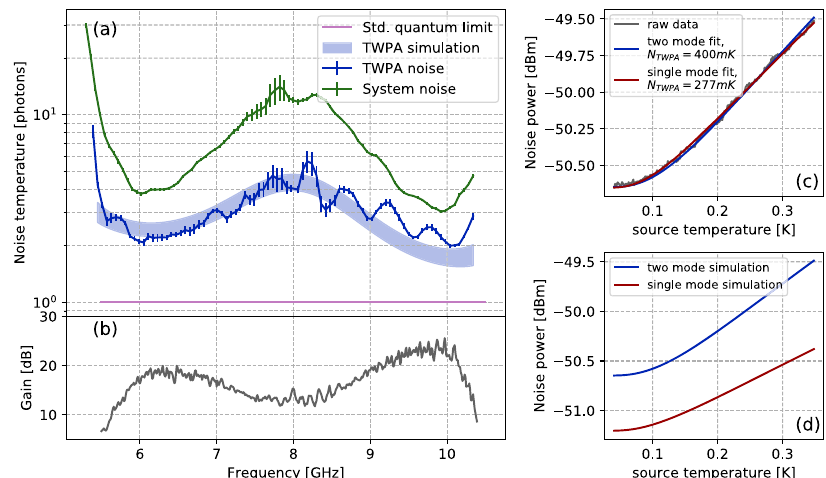
Fig. 4 Noise characterization. a Noise temperature of the ampli fi cation chain (green) and the reversed Kerr TWPA (blue) compared to the standard quantum limit (SQL) across ampli fi cation band in terms of number of added photons. The device is pumped at 8 GHz and tuned to external magnetic fl ux Φ Φ = 0.5. The blue shadow area indicates the result of the theoretical simulations considering power dependent losses. b Corresponding gain pro fi le. ext / 0 c Comparison between output noise power fi tted to noise models including and excluding idler mode noise input. Ignoring idler mode inaccurately leads to lower noise temperature estimates. d Comparison of simulated noise output for the noise models including and excluding idler mode with identical TWPA noise